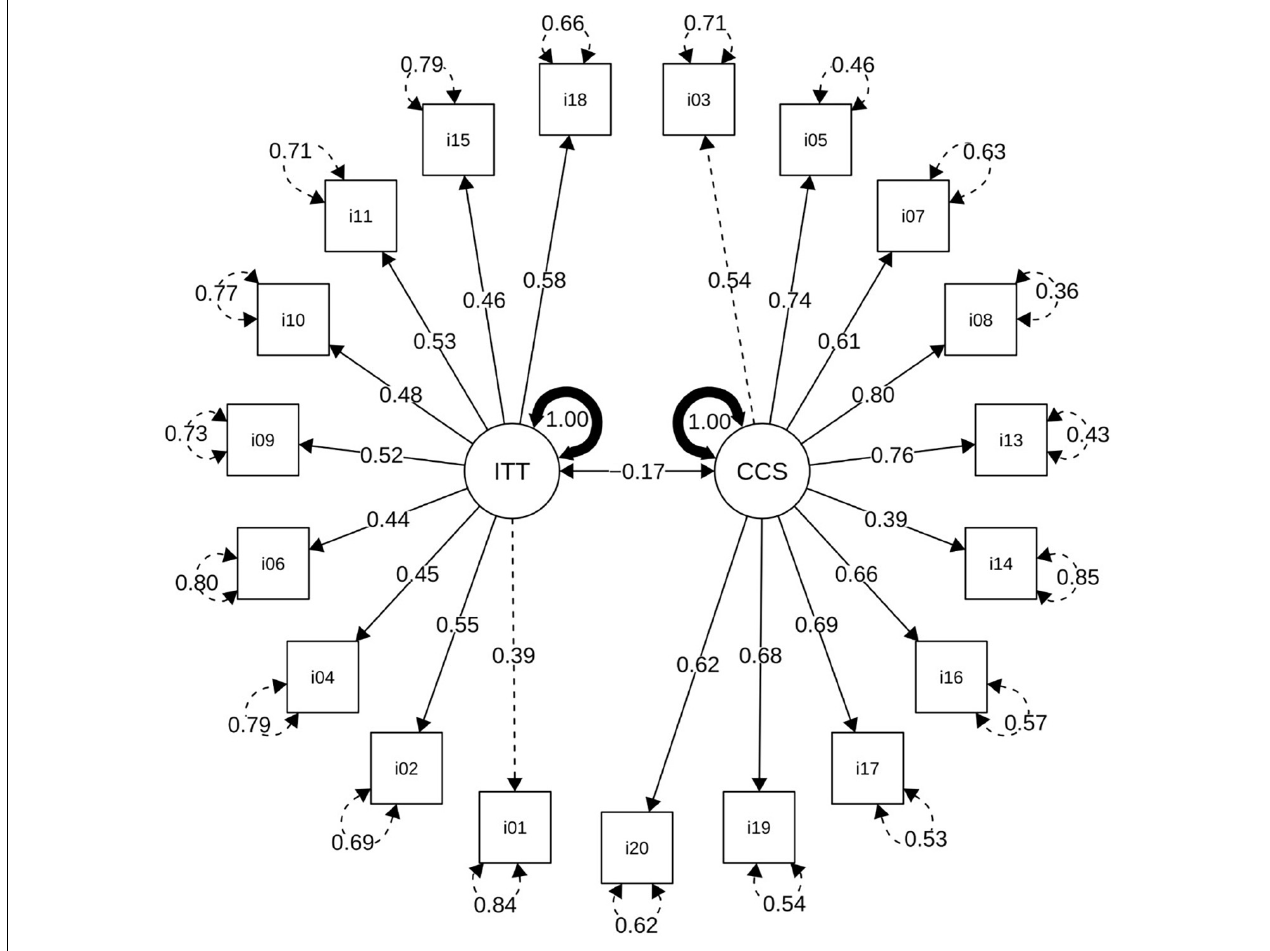
FIGURE 1 | Representation of the structural model. Own.